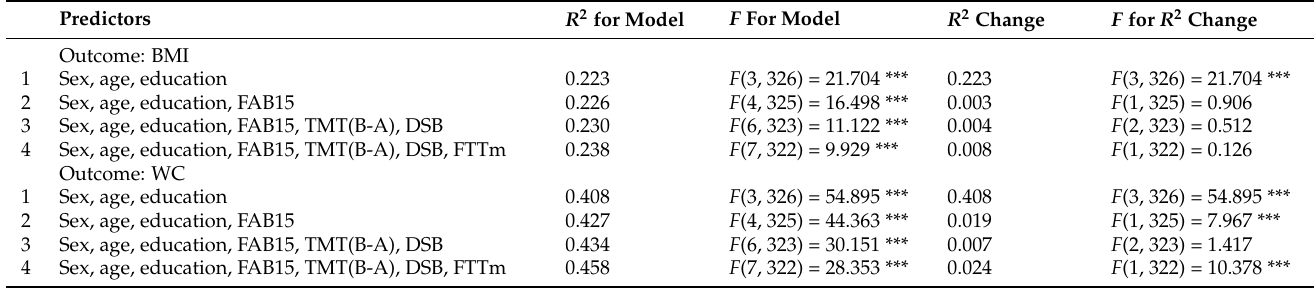
Table 2. R 2 change at each step hierarchical regressions on body mass index and waist circumference.